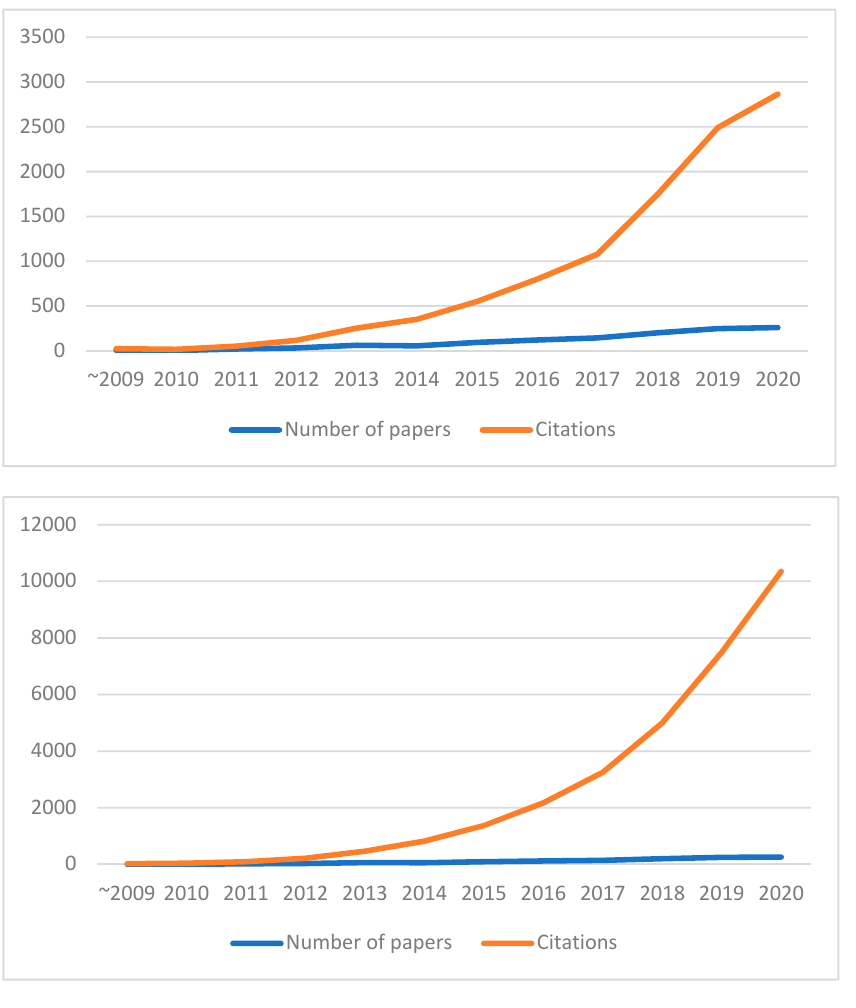
Figure 6. Annual number of papers and citations ( above : each year, bottom : cumulative annual).